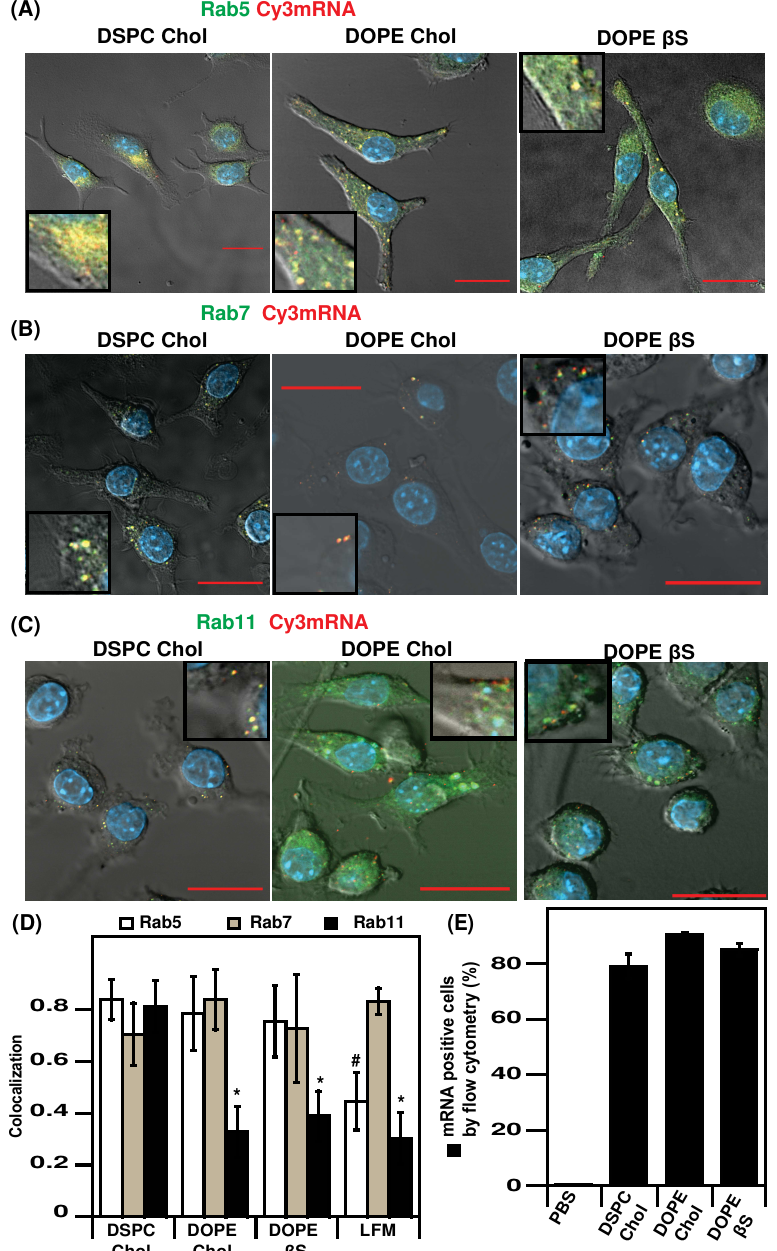
Figure 3. Intracellular trafficking of Cy3 mRNA-LNPs in DC 2.4 cells by confocal microscopy and flow cytometry: ( A ), Rab5-GFP colocalization with Cy3 mRNA; ( B ), Rab5-GFP colocalization with Cy3 mRNA; ( C ), Rab5-GFP colocalization with Cy3 mRNA; ( D ), Pearson’s colocalization coefficient quantification; ( E ), quantification of Cy3 mRNA-LNPs uptake in DC 2. cells by flow cytometry. Nuclei were stained with DAPI. Bar represents 20 µ m. Data are presented as mean ± SD, * p < 0.05 compared to DSPC/Chol LNPs., # p < 0.05 compared to all LNPs. Zoomed areas are shown in